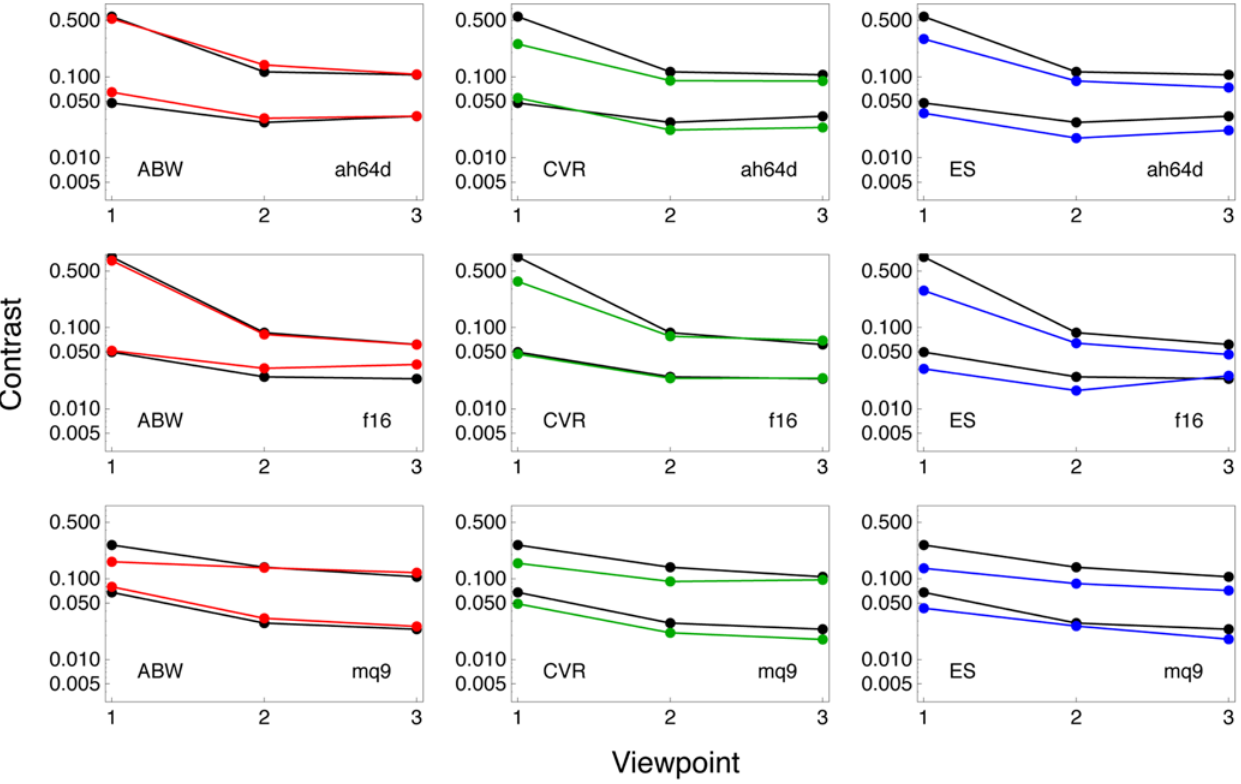
Figure 12. Contrast thresholds for three viewpoints of three aircraft at two sizes for three observers. SSO predictions are also shown in black. Each panel shows the data for one observer and one aircraft. The two colored curves in each panel are for the two sizes. The horizontal axis indicates the orientation of the aircraft. The stimuli for these data are shown in Figure 11.